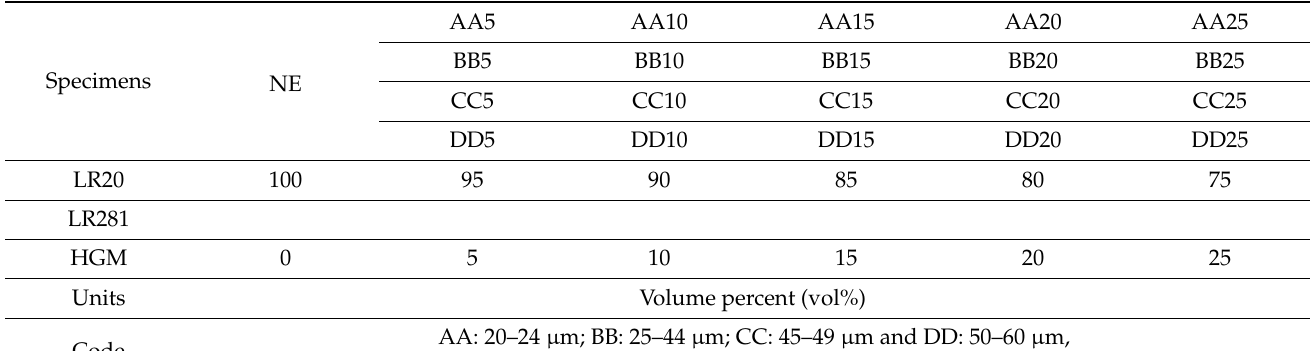
Table 1. Formulation for fabrication of e–SFCs.